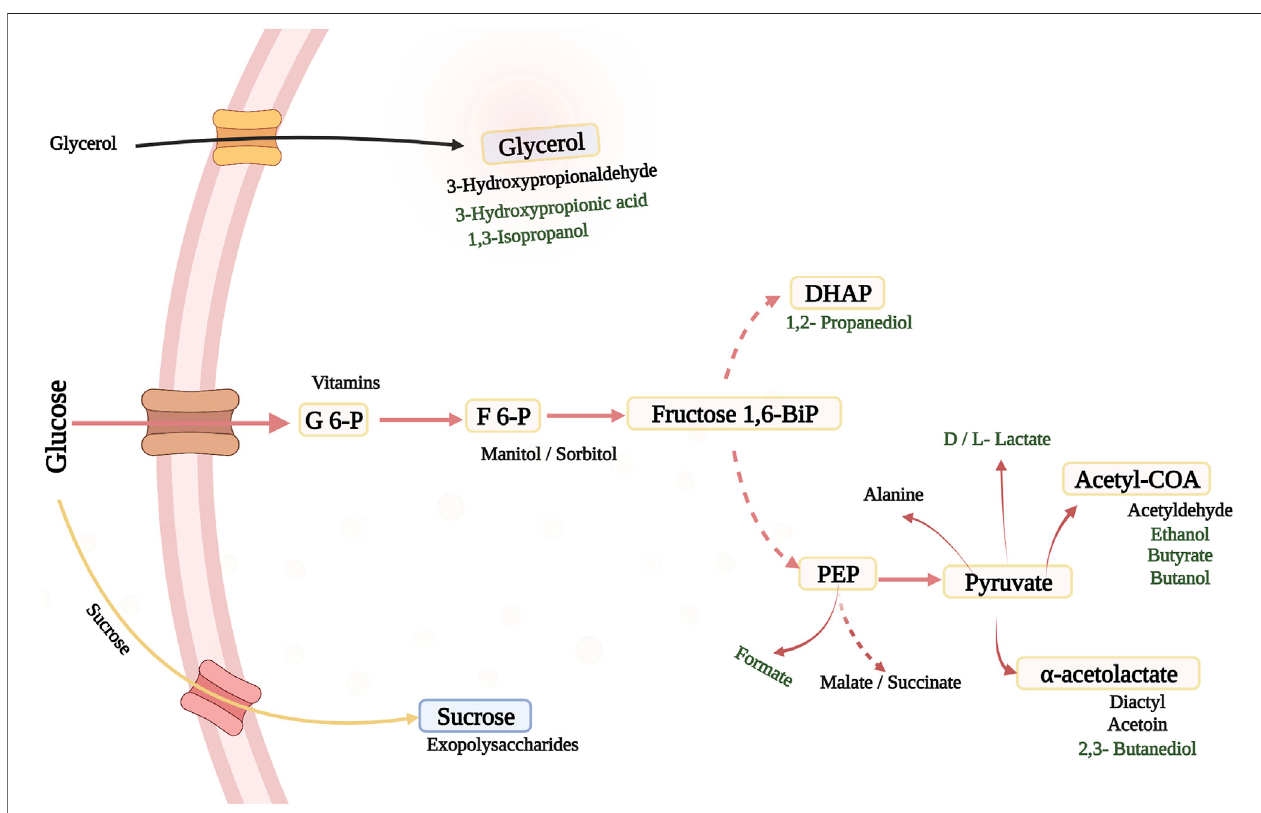
FIGURE1| PossibleProductsintheNaturalMetabolicPathwaysofLABandPediococciunderVariousConditions.Thedashedarrowsindicatedifferentenzymatic steps. Black: taste, texture, medicinal ingredients and health uses; Green: chemicals and fuels. F 6-P, fructose 6-phosphate; DHAP, dihydroxyacetone phosphate; Fructose 1,6BiP, fructose 1,6 bisphosphate; PEP, phosphoenolpyruvate; G 6-P, Glucose-6-Phosphate.